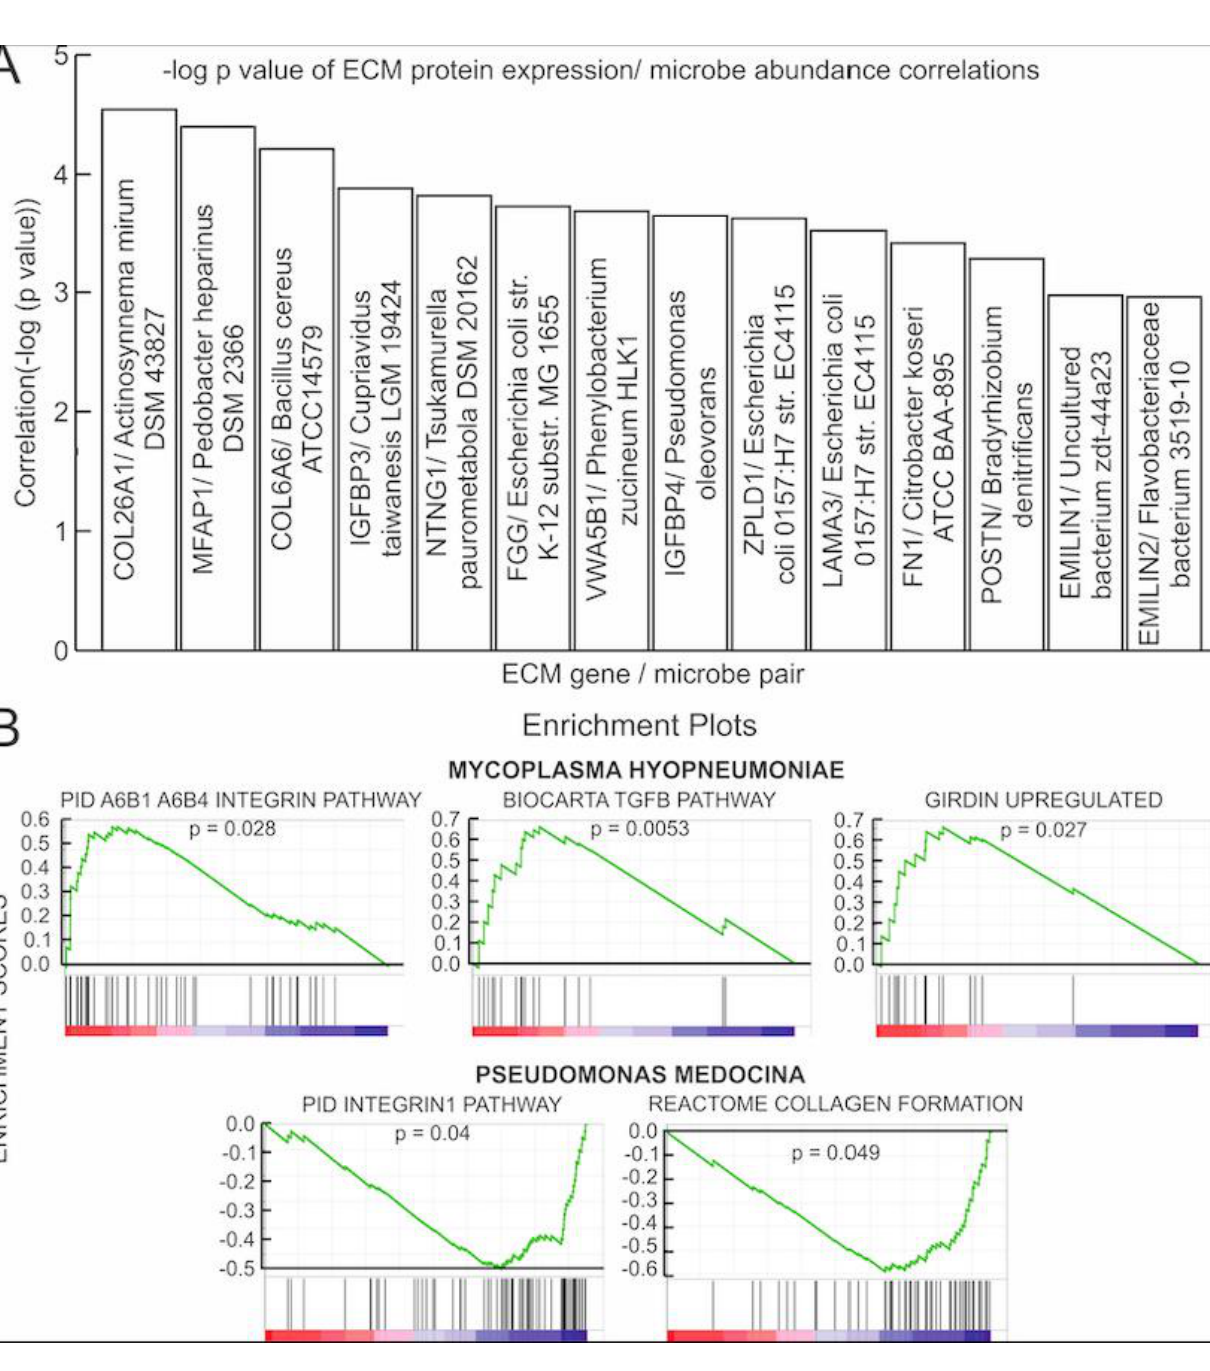
Figure 3. Microbe association with the ECM protein coding genes. ( A ) Bar graph of the Kruskal–Wallis correlation p -values. For each significantly correlated ECM gene/microbe pair, the negative logarithm of the p -value was plotted. ( B ) Gene set enrichment analysis (GSEA) plots correlating M. hypopneumoniae and P. mendocina abundance to the expression of a set of genes in ECM pathways. M. hypopneumoniae abundance correlated positively to expression of genes in the girdin, integrin, and TGFB pathways. P. mendocina abundance correlated negatively with expression of genes in collagen and integrin pathways. A list of genes in each pathway can be found in Table S1A.